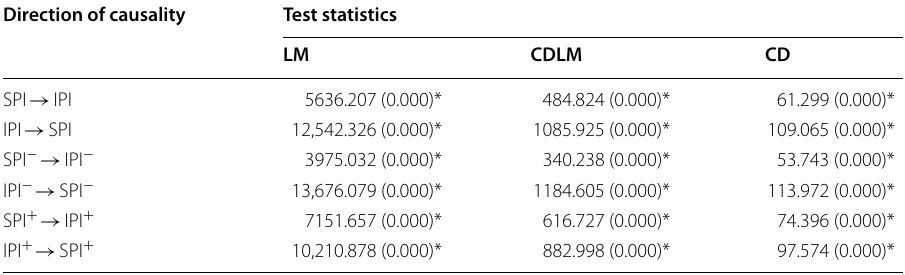
The numbers in the parentheses show the p values *The significance at the 1%